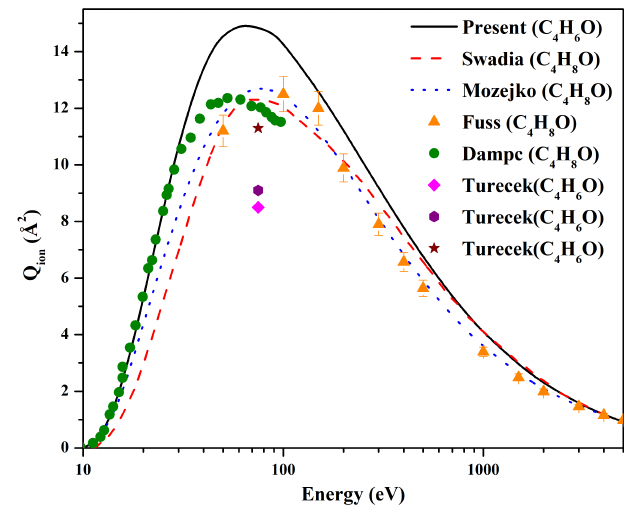
Figure 5. Q ion for furan, 2, 5-dihydro. Solid line: present Q ion ; dash line: Q ion for THF by Swadia et al. [13]; dotted line: Q ion for THF by Mozejko et al. [14]; solid triangle: Q ion for THF by Fuss et al. [18]; solid circle: Q ion for THF by Dampc et al. [16]; solid rhombus and solid hexagonal: experimental Q ion for furan, 2, 5-dihydro by Tureˇcek et al. [12] and solid star: theoretical Q ion for furan, 2, 5-dihydro by Tureˇcek et al. [12].